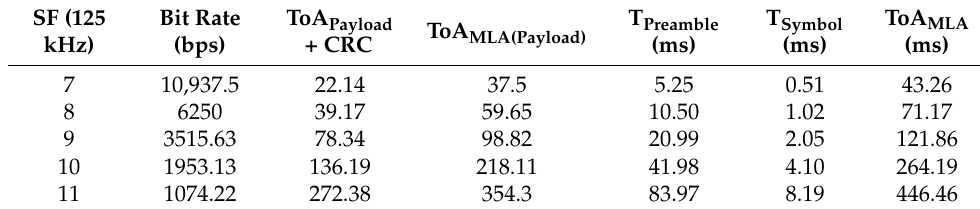
Table 7. Multi-gateways based on K-means MLA.